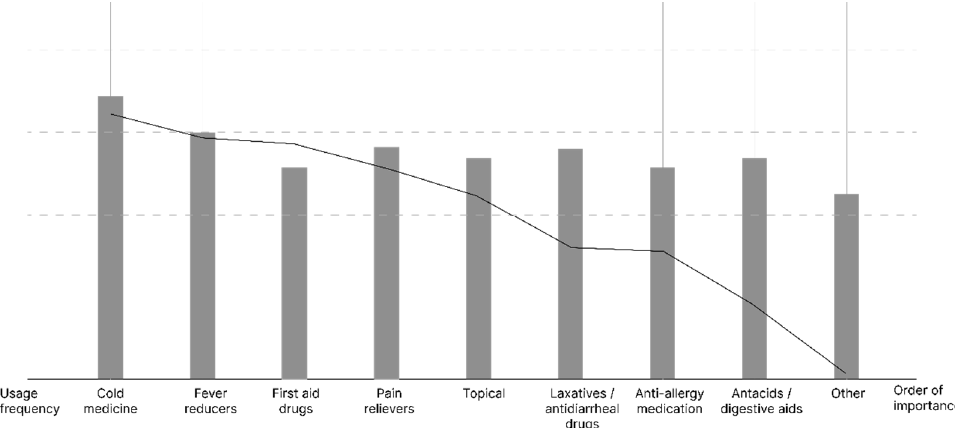
Figure 11. Frequency and importance of different types of drugs correlation analysis chart.